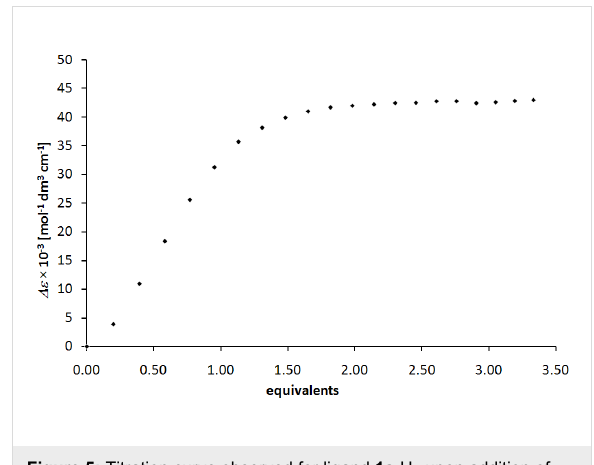
Analysis of the titration data reveals high binding constants for lanthanum(III) ( K a = 8.3 × 10 5 M −1 ) as well as europium(III) ( K a = 7.8 × 10 5 M −1 ) for the reaction of deprotonated ligand 1a 3− with the Ln 3+ ion to form [( 1a )Ln] in methanol at room